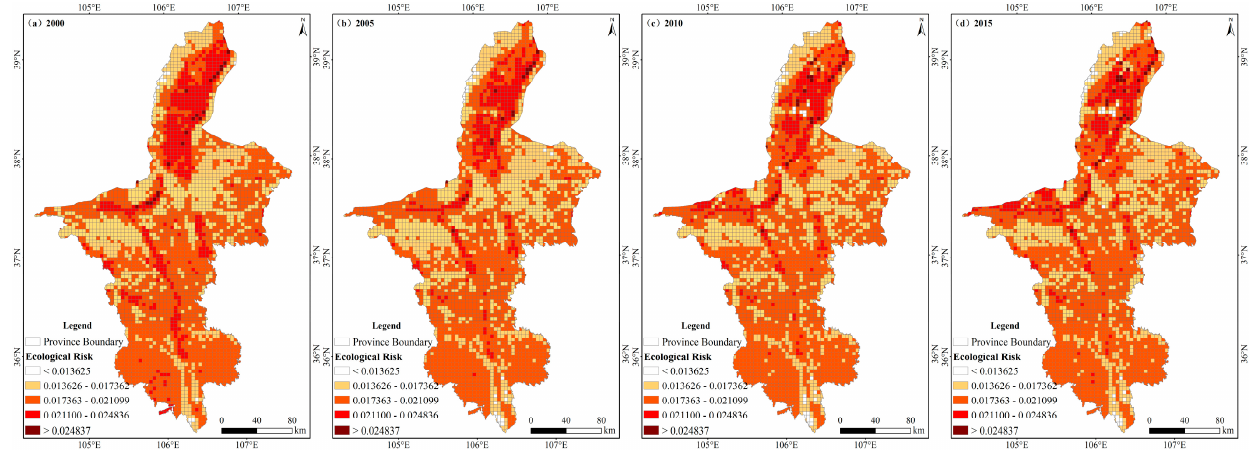
Figure 8. The assessment results of LER units in Ningxia from 2000 to 2015.